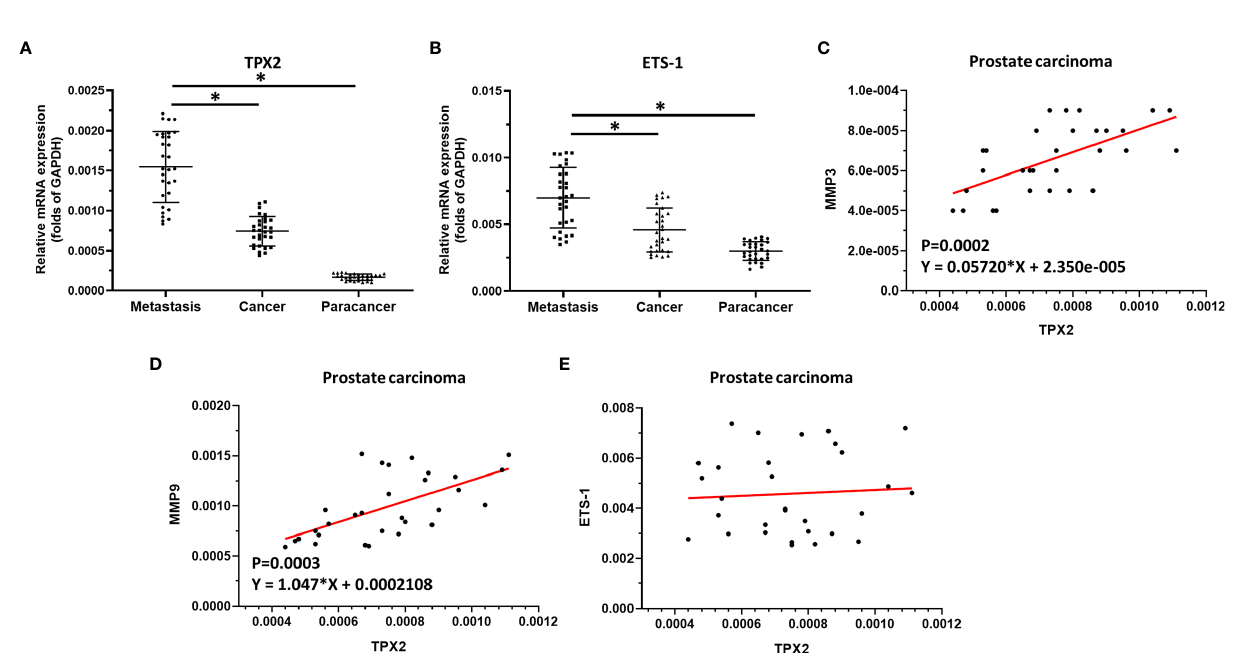
FIGURE 4 | The signi fi cance of TPX2 in clinical specimens. (A) The expression of tpx2 in non-tumor specimens, primary prostate carcinoma specimens or metastatic prostate specimens by qPCR. (B) The expression of ets-1 in non-tumor specimens, primary prostate carcinoma specimens or metastatic prostate specimens by qPCR. (C – E) The co-relationship between tpx2 and mmp3 (C) or mmp9 (D) or ets-1 (E) was shown as scatter-plot images. *refers multiplication